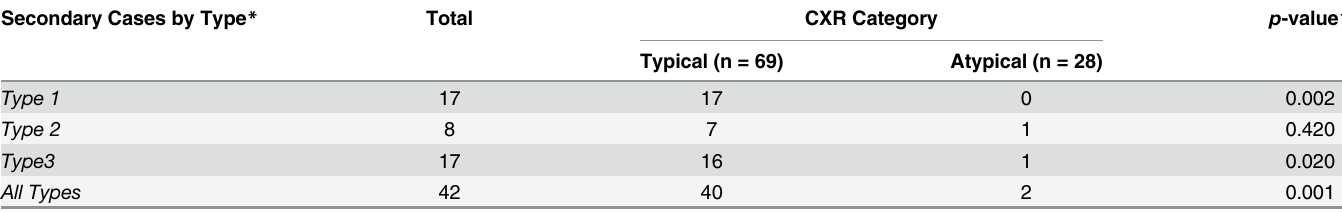
Table 6. Secondary cases among smear-positive PTB patients according to chest radiograph